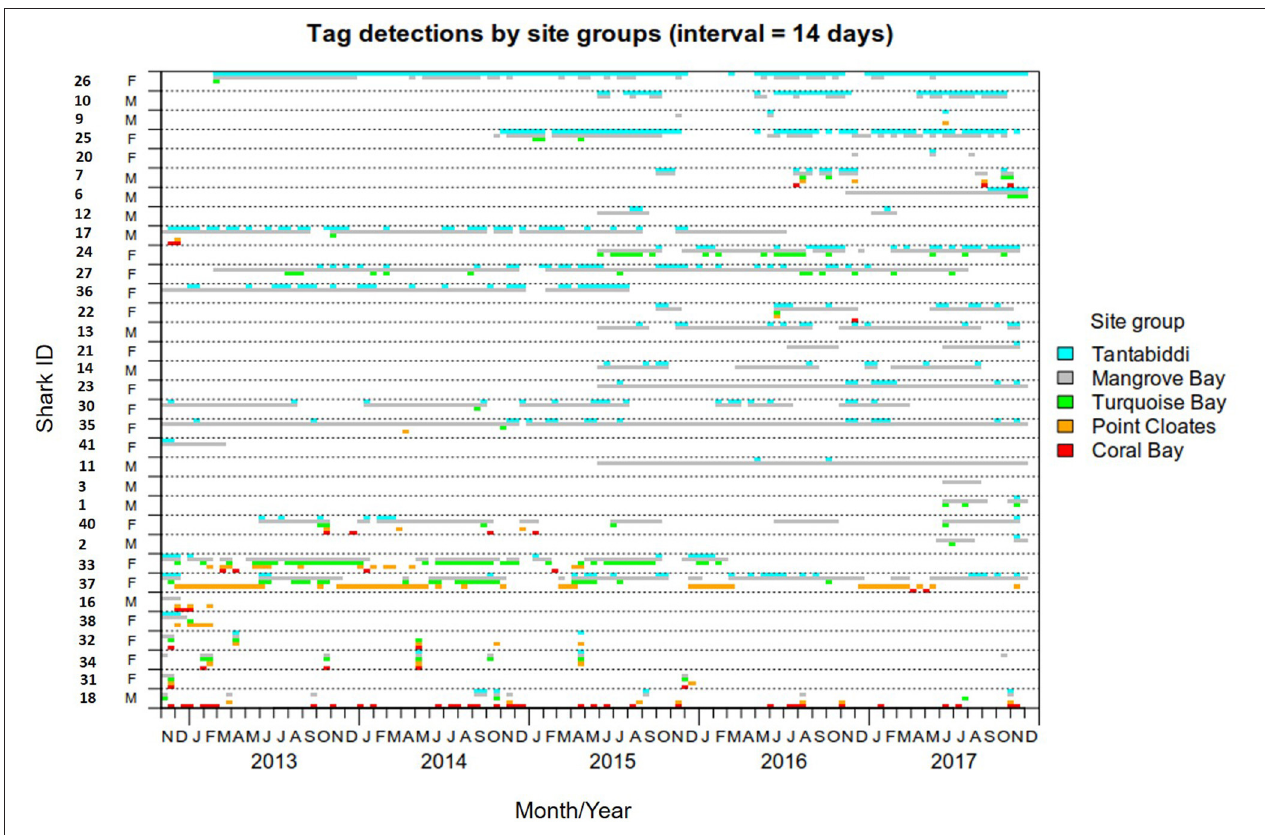
FIGURE 3 | Detection span of 33 lemon sharks detected at more than one site group. Detections were binned into 14 days intervals and color coded by site